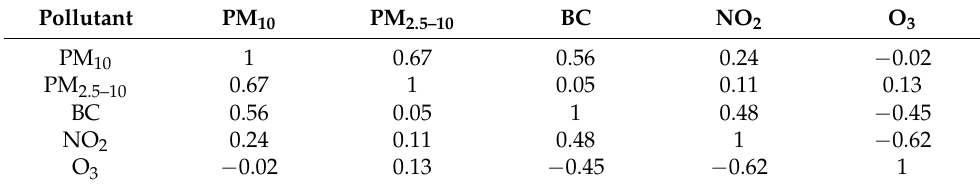
Table A3. Correlation matrix with R-values (Pearson correlation coefficients) between the different air pollutants measured in Stockholm during wintertime (December, January and February) during the period from 2000 to 2016.